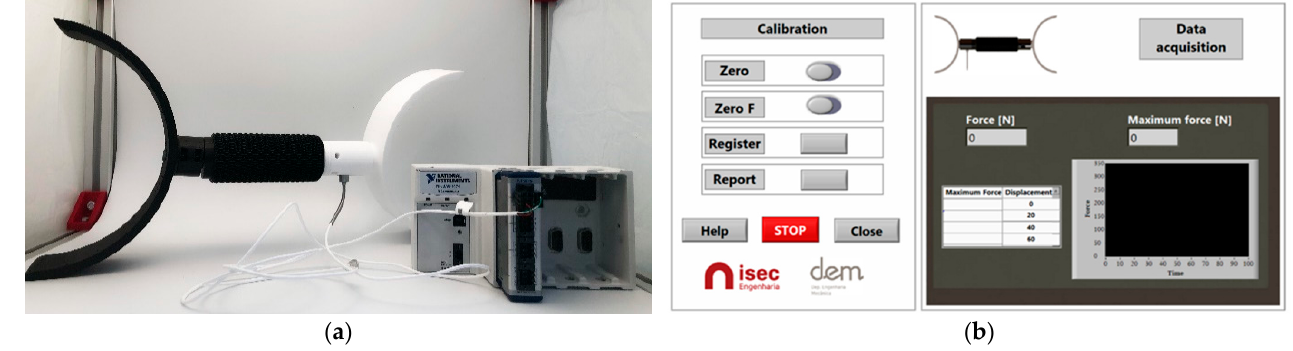
Figure 8. ( a ) Instrumented device; ( b ) Interface of Labview program to connect the load cell.